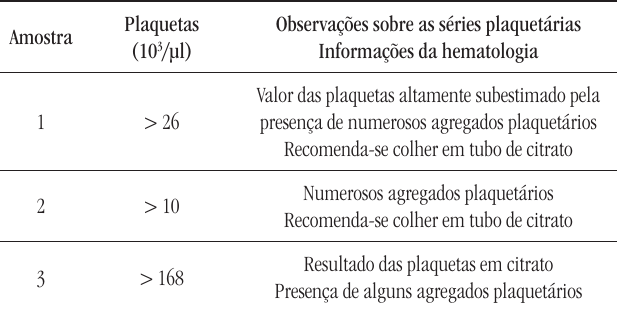
tabela 2 – Resultados de plaquetas liberados e